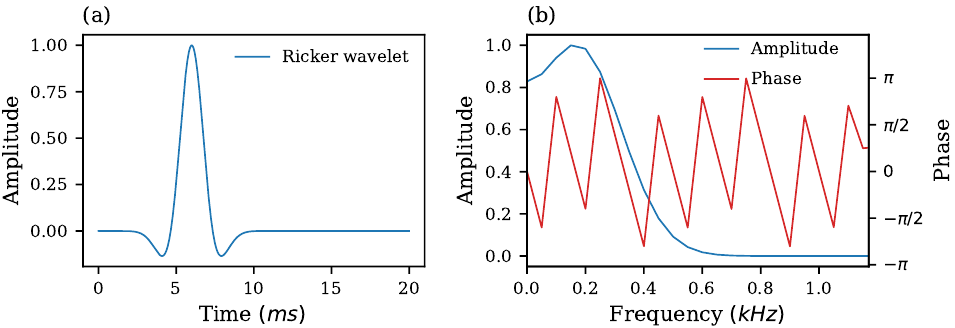
Figure 14. Ricker wavelet of unit amplitude with center frequency 250 Hz used as velocity source for the excitation in FWI model: ( a ) normalized amplitude in time domain, ( b ) normalized amplitudes in frequency